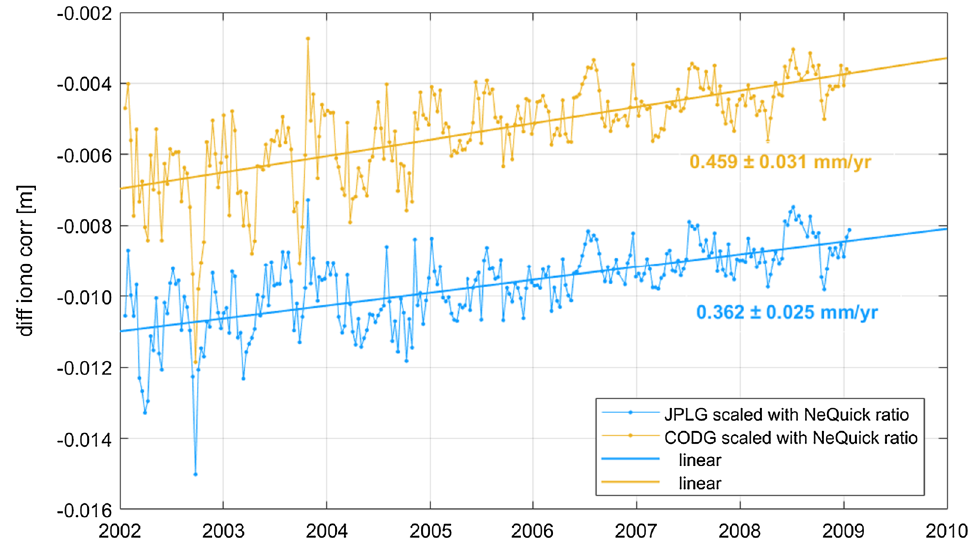
Fig. 8 Trend differences to smoothed dual-frequency altimeter for two different GIM types (JPLG in blue and CODG in orange); both scaled with NeQuick ratio (solution 3)